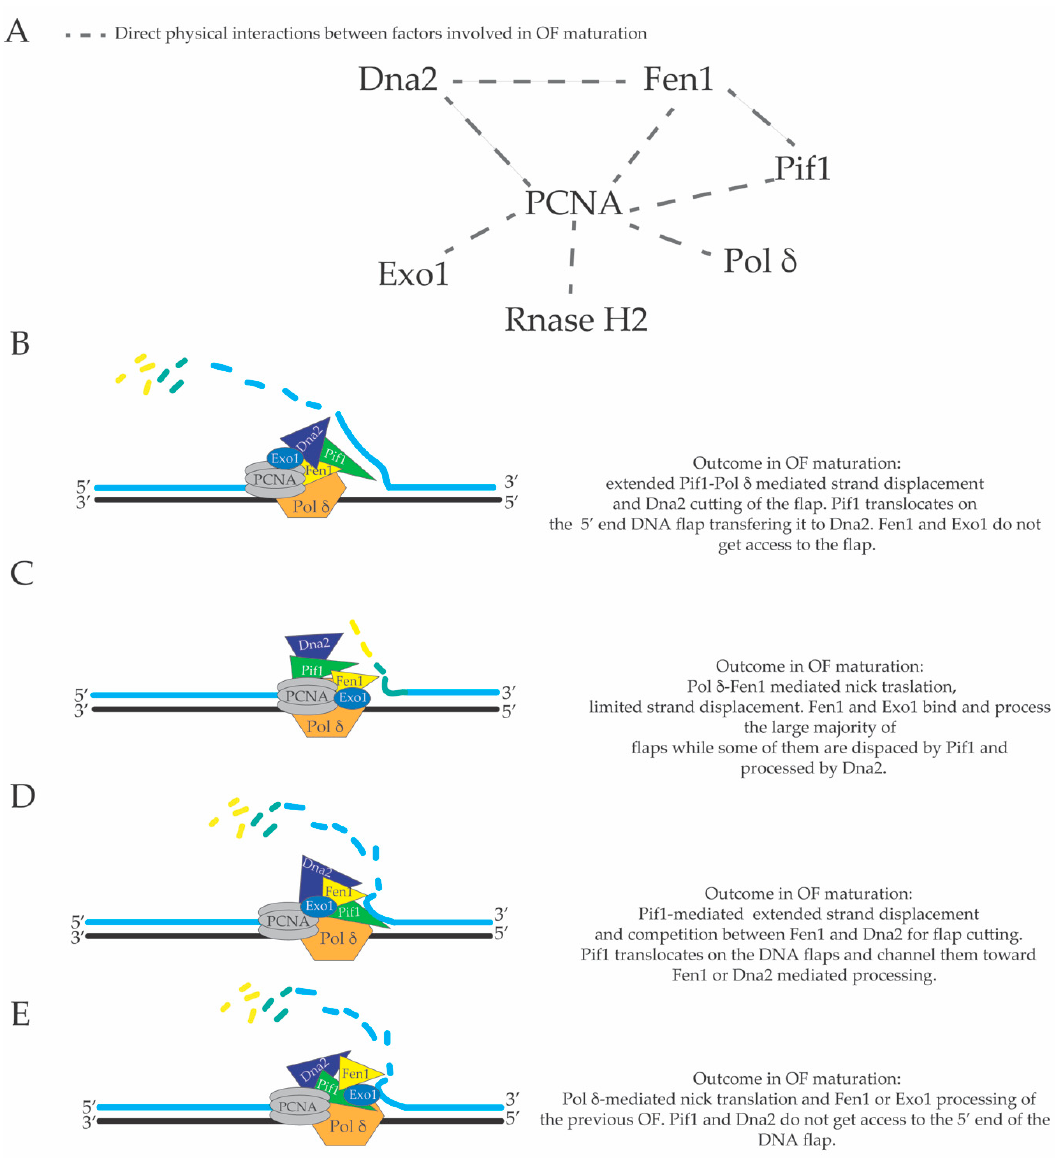
Figure 5. ( A ) graphical map of the direct physical interactions of factors involved in OF processing. Different mechanisms of OF processing dictated by different structural architectures of the complex Pif1-PCNA-Dna2-FEN1-Pol δ macromolecular assembly ( B – E ) .